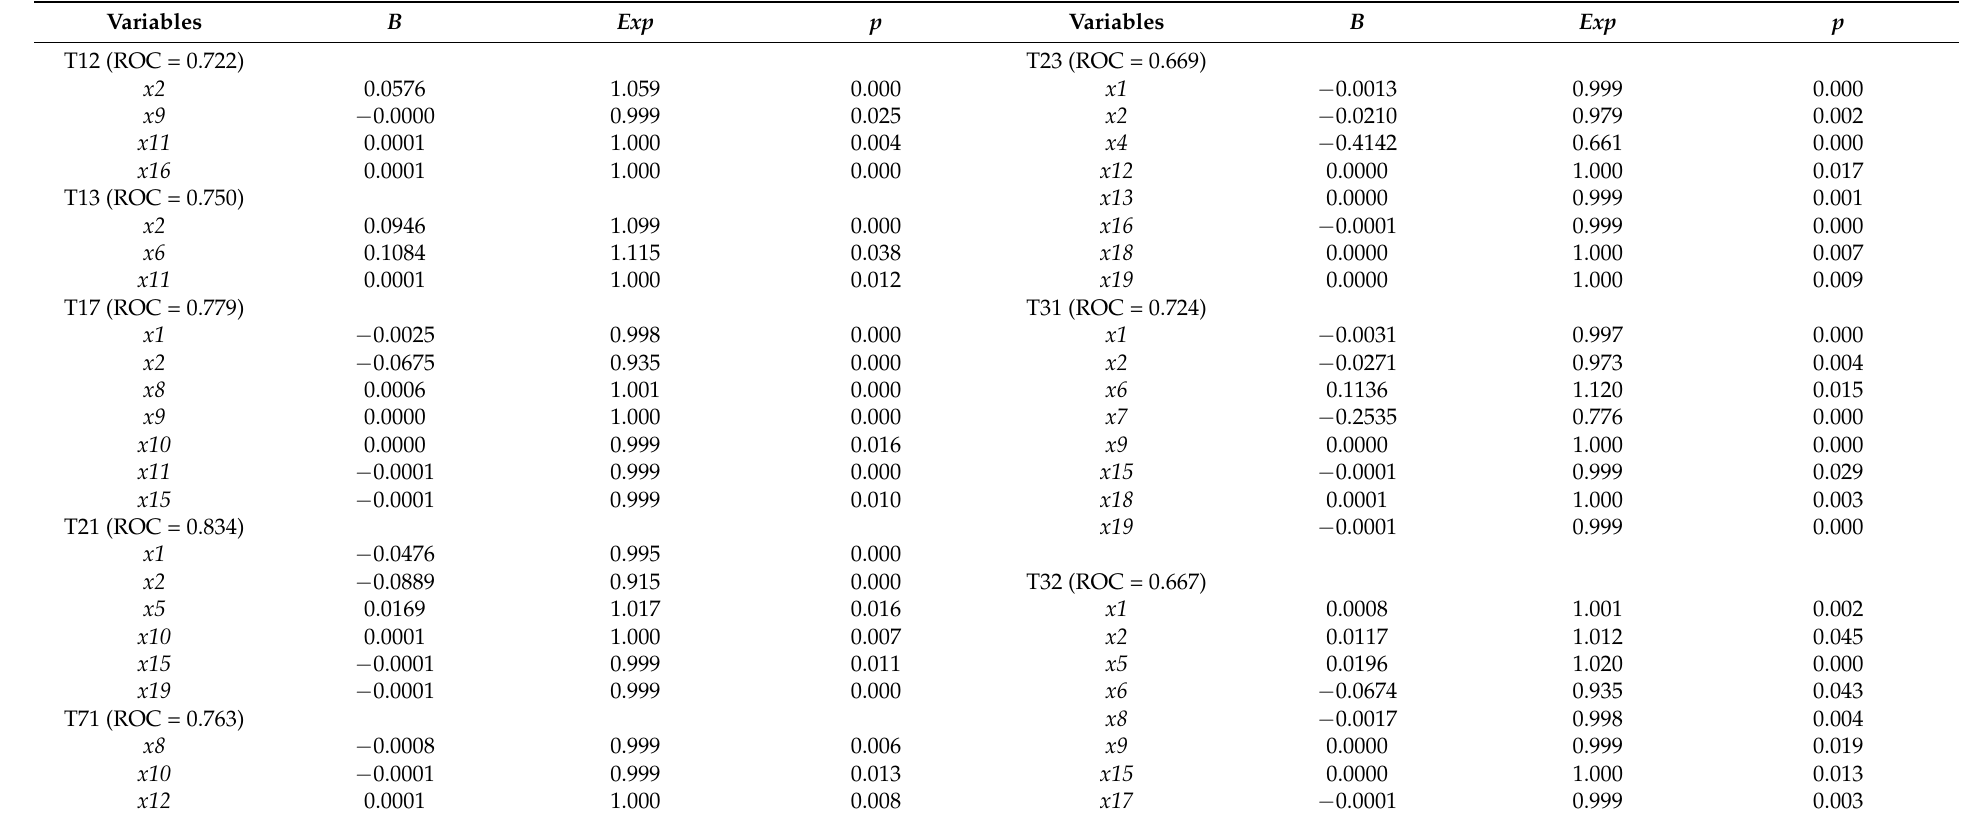
Table 3. Analysis of the drivers of land class